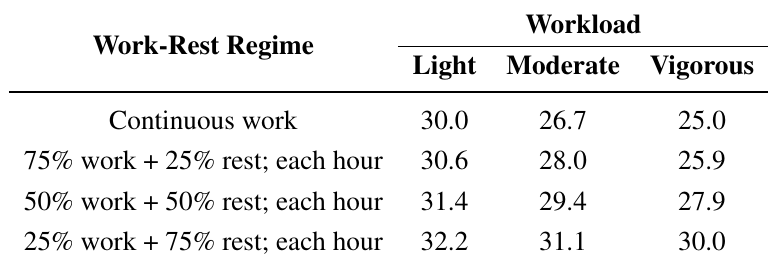
Table 4. Wet bulb globe thermometer (WBGT) limit temperature ( ◦ C) values in accordance with